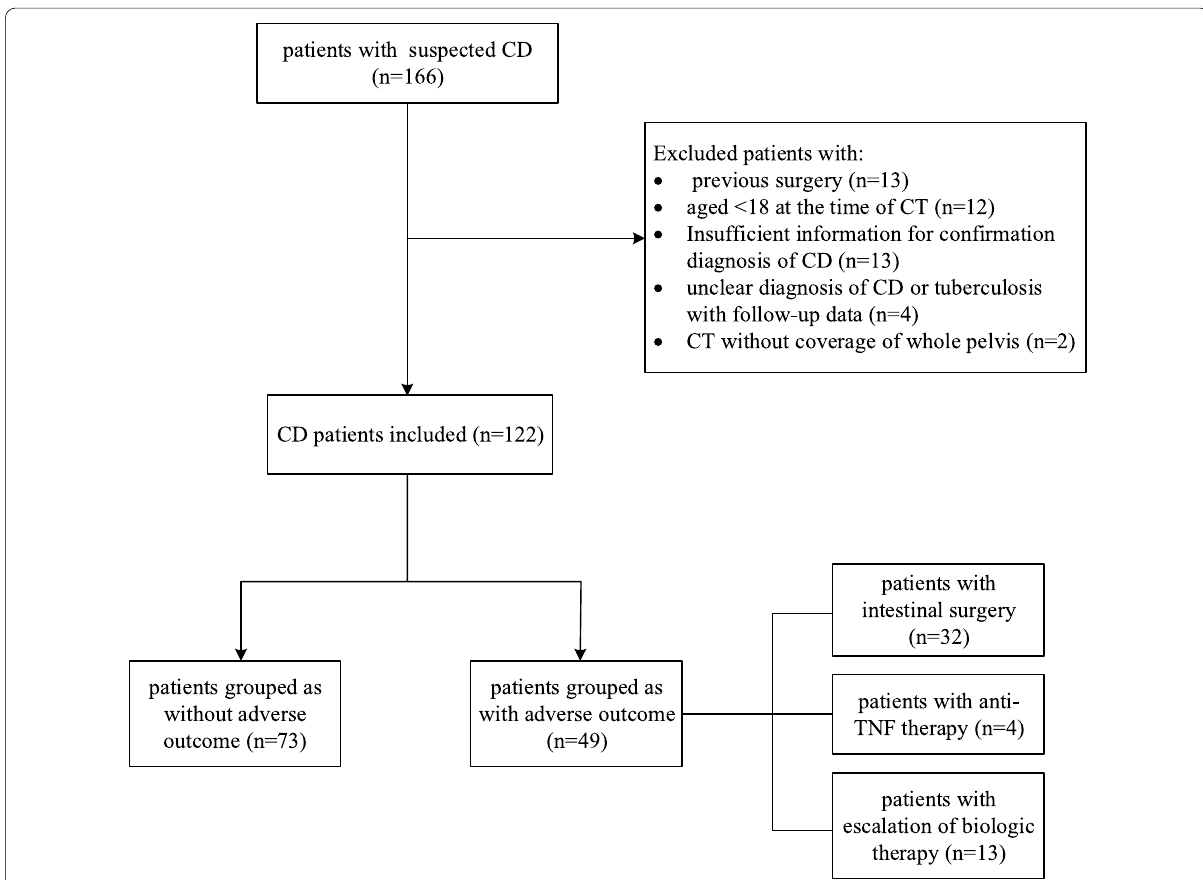
Fig. 1 Flowchart of study population. CD Crohn’s disease, CT computed